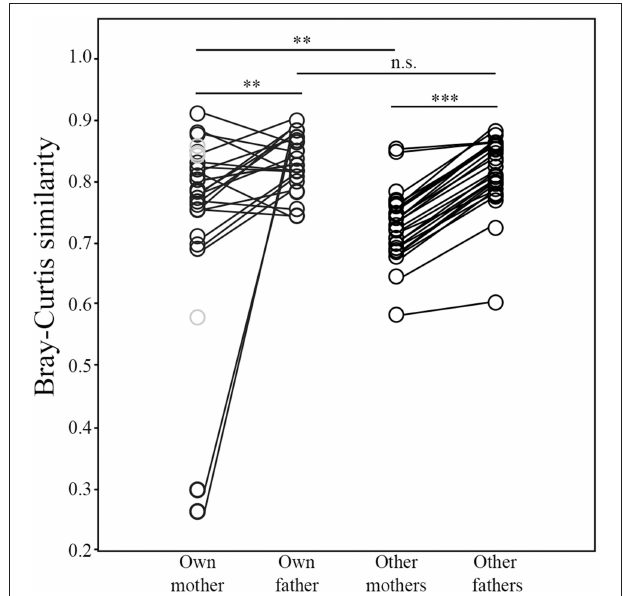
FIGURE 8 | Comparisons of similarities in the structure of the uropygial gland volatile profiles between nestling juncos with those of their own mother and father, and those of other adult females and males in the population (** p ≤ 0.01; *** p ≤ 0.001). The samples colored gray denote the 4 nestlings that did not have an attendant